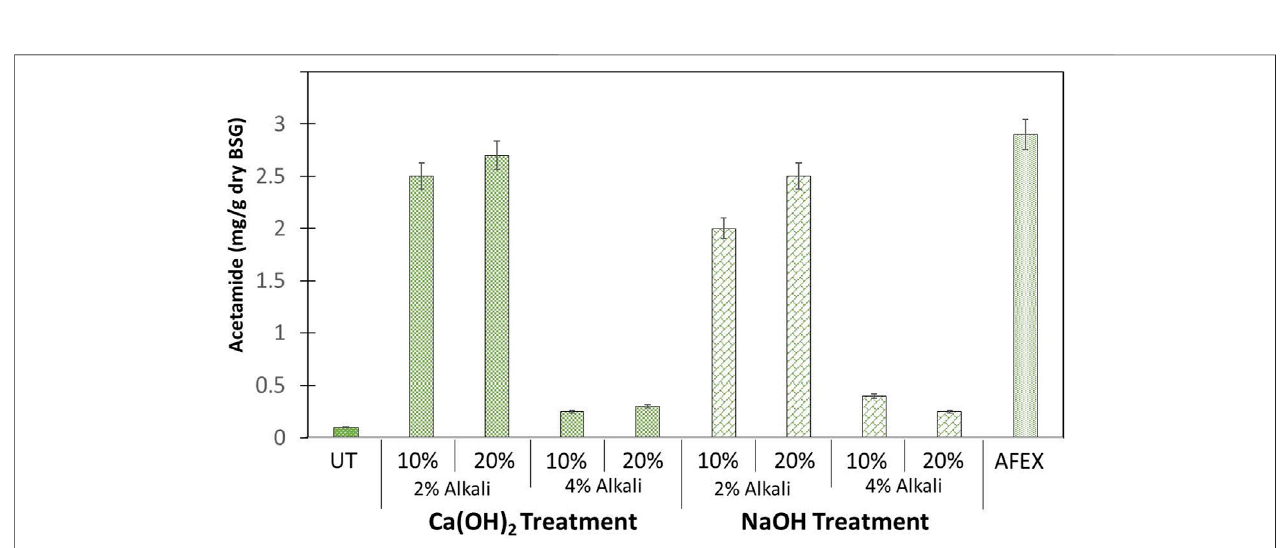
FIGURE 5 | Amount of acetamide (mg/g dry weight) present in untreated (UT) BSG, AFEX pretreated BSG, and two different alkalies [NaOH and Ca(OH) 2 ] treated de-esteri fi ed BSG followed by AFEX pretreatment. Here, two different solids loading (10 and 20%) and two different alkali concentrations (2 and 4%) were used during de-esteri fi cation of BSG prior to AFEX pretreatment. Error bars represent the standard deviation of two replicated experimental points.